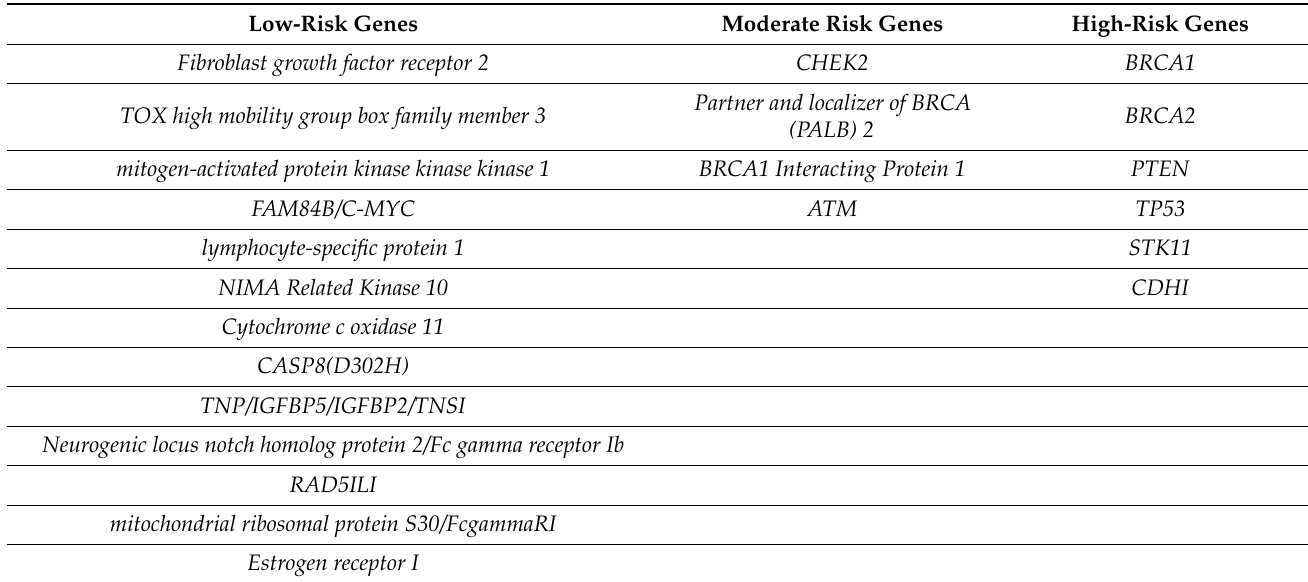
Table 1. List of known breast cancer